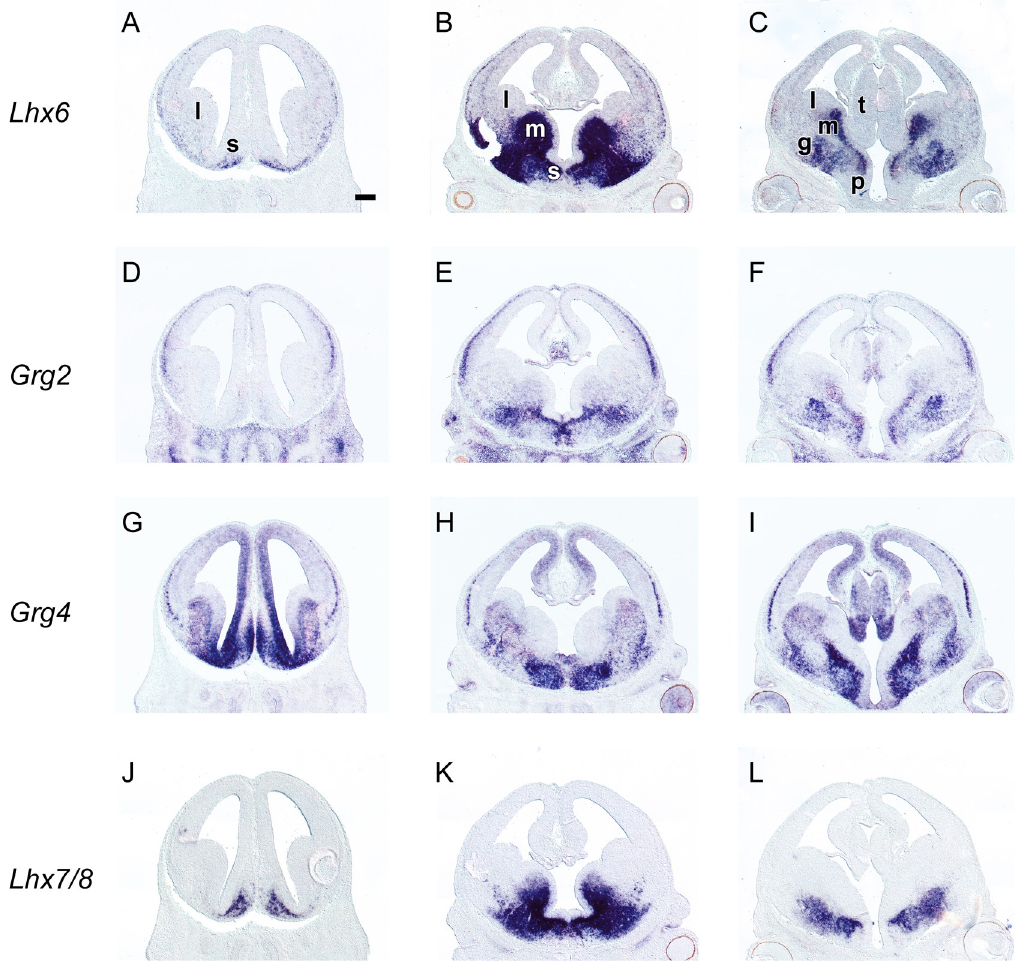
Fig 8. In situ hybridization on adjacent coronal sections through the embryonic telencephalon at E13.5 from rostral (left) to caudal (right) levels hybridized with an antisense RNA probe of Lhx6 (A—C), Grg2 (D—F), Grg4 (G-I) and Lhx7/8 (J—L) m: MGE, l: LGE, l: LGE, s: septum. Scale: 250 μ m.